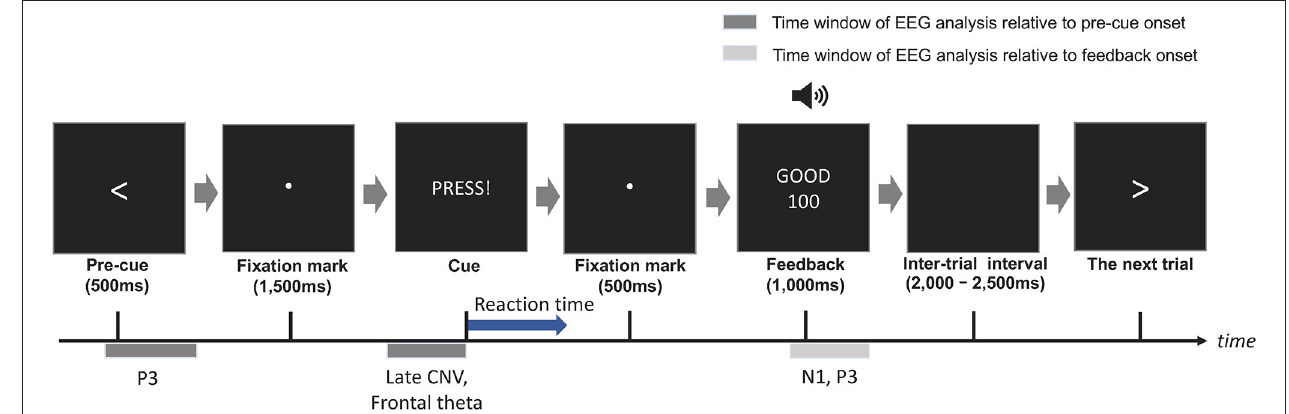
FIGURE 2 | Reaction task procedure for pressing the experimental switches. Participants pressed the target switch as soon as possible after the cue (“PRESS!”) was presented at the center of the display. Auditory and visual feedbacks regarding their RTs was presented on every trial.